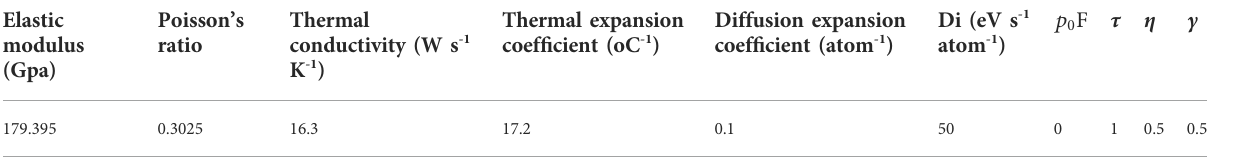
TABLE 1 Corresponding parameters and coef fi cients for simulation and calculation. Elastic